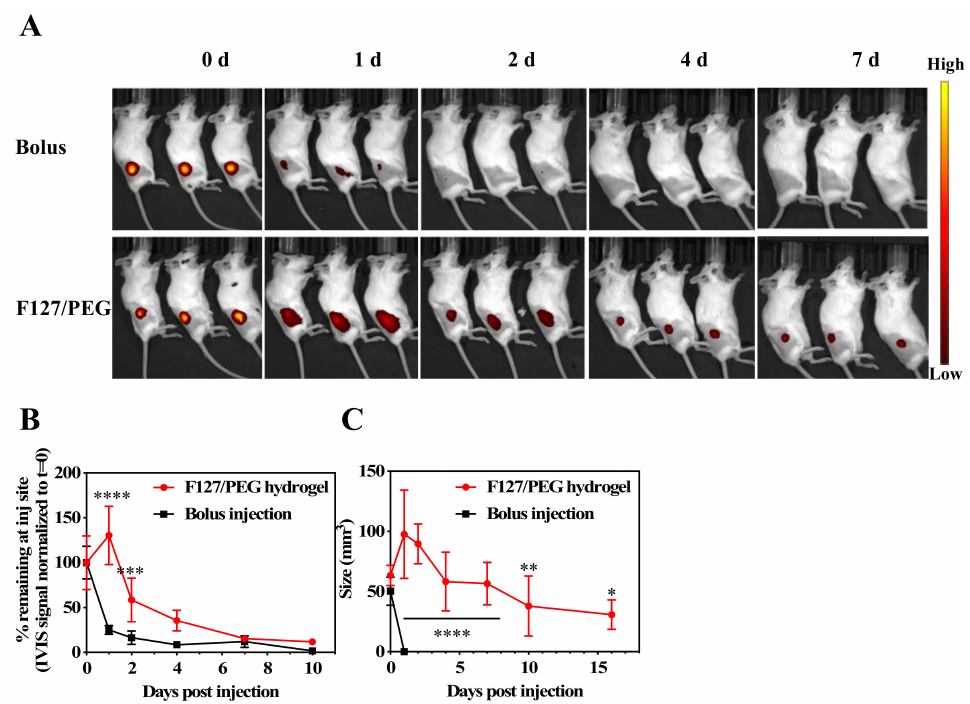
Figure 2. Antibody release from in situ crosslinked F127/PEG hydrogels in vivo . ( A ) Time-resolved IVIS images of Alexa Fluor™ 647-labeled aCTLA-4 antibody dermally injected with bolus or within 2.7% ( w / v ) F127/PEG hydrogels. ( B ) Quantification of IVIS fluorescence at the injection site. ( C ) In vivo stability of F127/PEG hydrogels. **** p < 0.0001, *** p < 0.001, ** p < 0.01, and * p < 0.05, which were analyzed with a two-way ANOVA